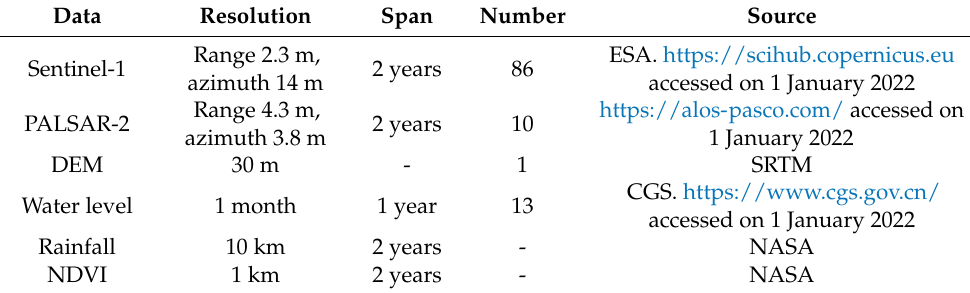
Table 1. Data and parameters.